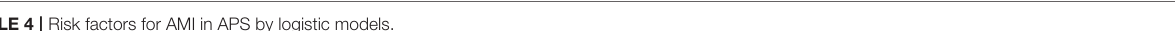
Overall With AMI